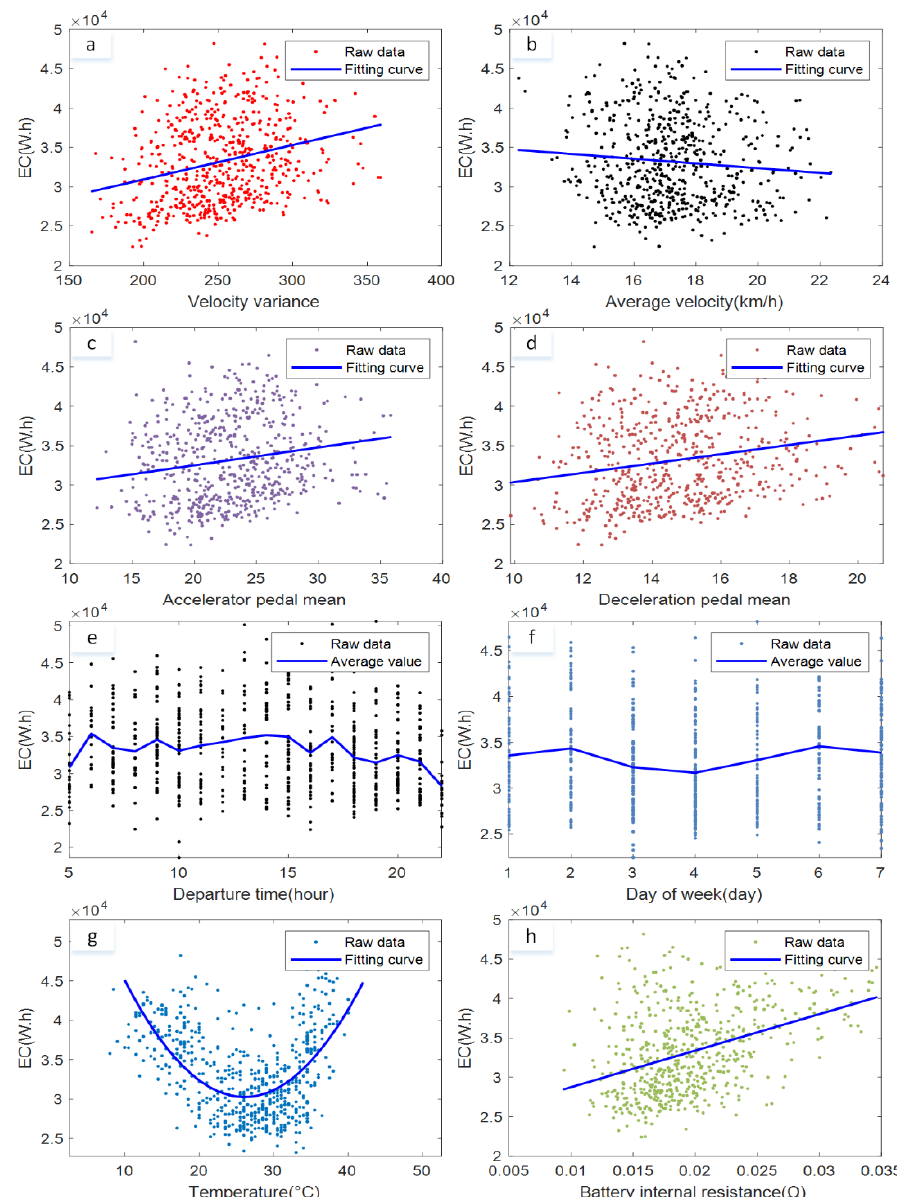
Figure 3. The statistical results of the impact of various energy consumption fluctuation factors on vehicle energy consumption. ( a – h ) The relationships between the velocity variance, average velocity, number of accelerator pedal presses, number of deceleration pedal presses, departure time, departure date, ambient temperature, internal resistance of the battery pack and energy consumption, respectively.